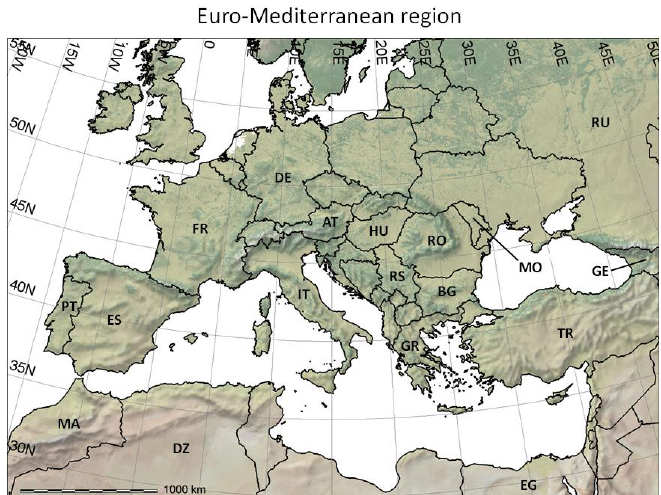
Figure 2. The Euro-Mediterranean part of the Western Palearctic region considered in the present paper, including shaded relief and land cover coloring based on satellite observations (form http://www.naturalearthdata.com/), and two-letter country codes (i.e., ISO 3166-1 alpha-2 codes, https://en.wikipedia.org/wiki/ISO_3166-1_alpha-2) used in this study to identify countries of interest. DZ = Algeria; AT = Austria; BG = Bulgaria; EG = Egypt; FR = France; DE = Germany; GR = Greece; HU = Hungary; IT = Italy; MO = Moldova; MA = Morocco; PT = Portugal; RO = Romania; RU = Russia; RS = Serbia; ES = Spain; TR = Turkey.